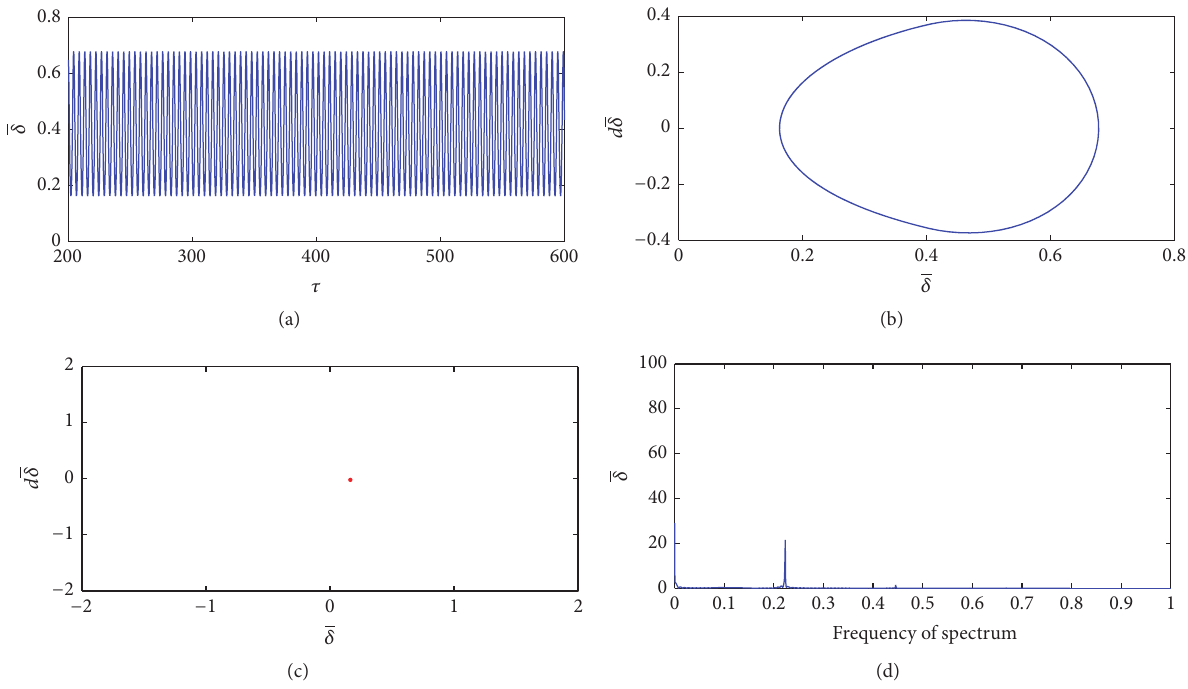
Figure 7: 𝜔 ℎ = 1.8 and 𝑓 = 2 : (a) time history; (b) phase plane;(c) Poincar´e map; (d) Fourier spectrum.